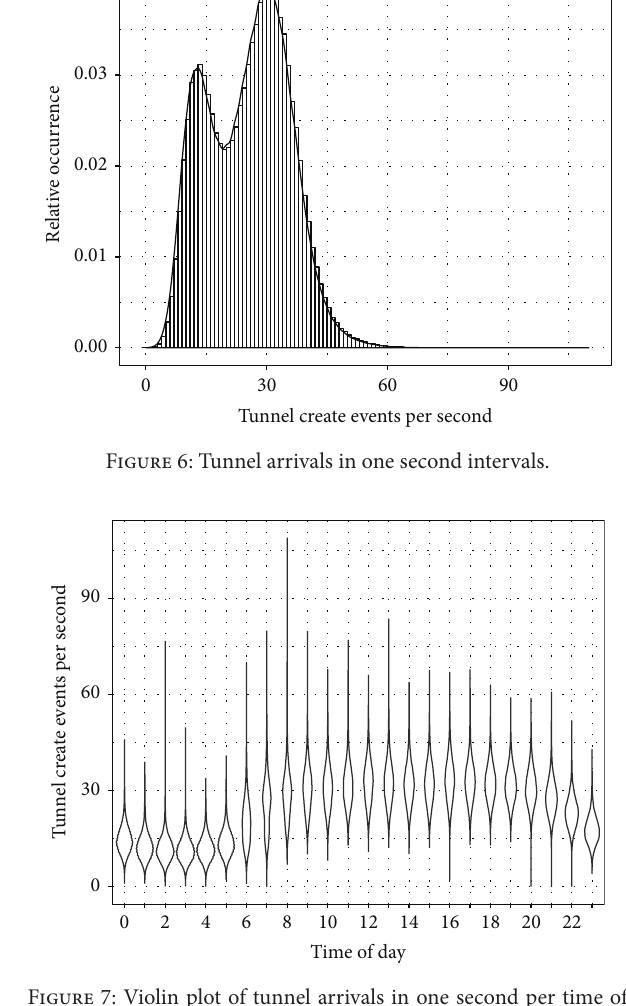
Figure 7: Violin plot of tunnel arrivals in one second per time of